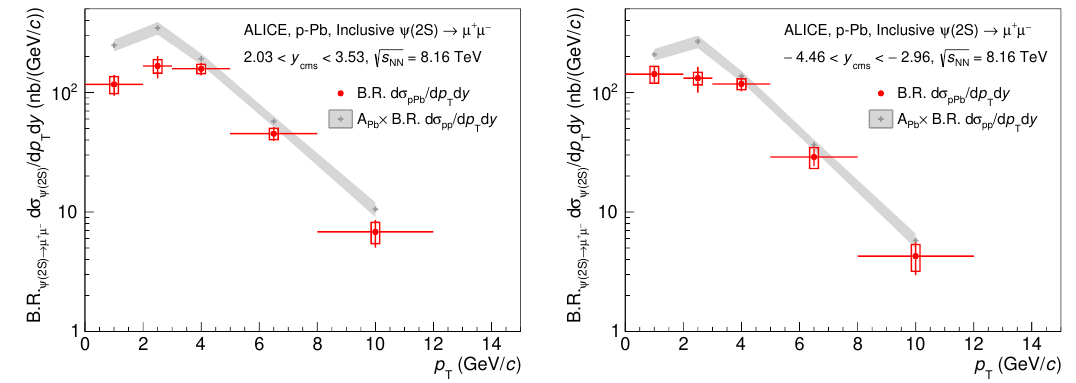
Figure 3 . The di(cid:11)erential cross sections B : R : d 2 (cid:27) (2S) = d y d p T for p-Pb collisions at (2S) ! (cid:22) + (cid:22) (cid:0) p s NN = 8 : 16 TeV, shown separately for the forward and backward y cms samples. The error bars represent the statistical uncertainties, while the boxes correspond to total systematic uncertainties. The latter are uncorrelated among the points, except for a very small correlated uncertainty (0.5% and 0.7% for the forward and backward y cms samples, respectively). The grey bands correspond to the reference pp cross section scaled by A Pb .